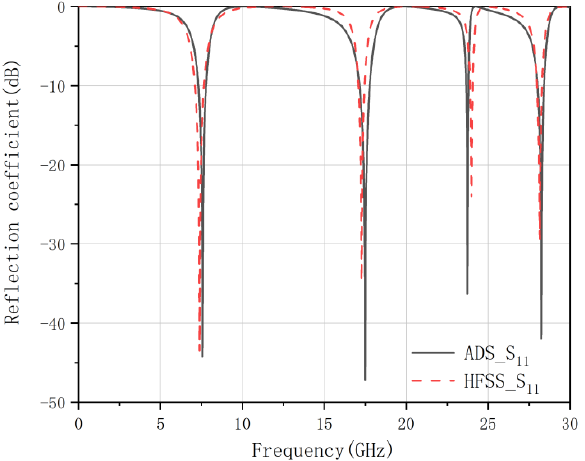
Figure 6. Equivalent circuit model diagram ( C 1 = 0.0196 pF, C 2 = 0.109 pF, C 3 = 0.0107 pF, C 4 = 0.0314 pF, C 5 = 0.0274 pF, C 6 = 0.0045 pF, L 1 = 3.275 nH, L 2 = 2.255 nH, L 3 = 2 nH, L 4 = 2.26 nH, L 5 = 1.5675 nH, L 6 = 6.465 nH).